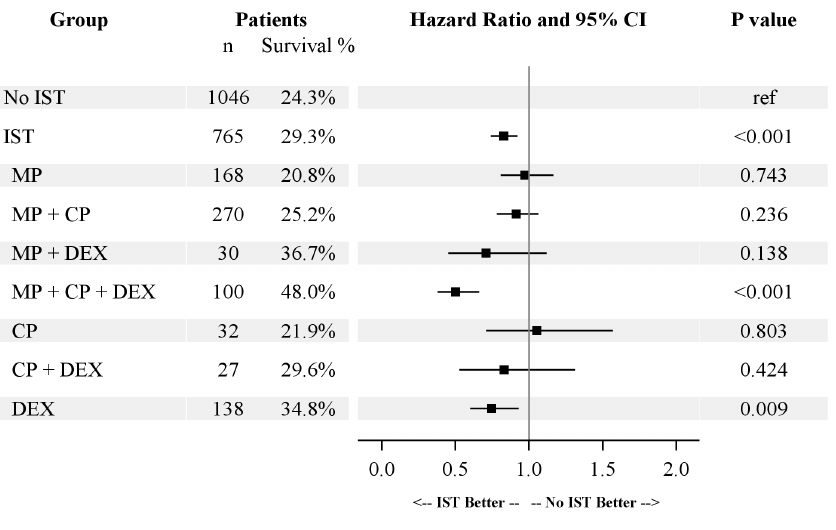
Figure 3. Treatment effects of different immunosuppressive regimens in paraquat-poisoned patients with hemoperfusion treatment. Cox regression analysis of mortality rates among different treatment groups, adjusted for age and sex, was used to calculate the hazard ratio. Abbreviations: No IST: No immunosuppressive treatment (Hemoperfusion alone); IST: Immunosuppressive treatment; MP: Methylprednisolone; CP: Cyclophosphamide; DEX: Dexamethasone.